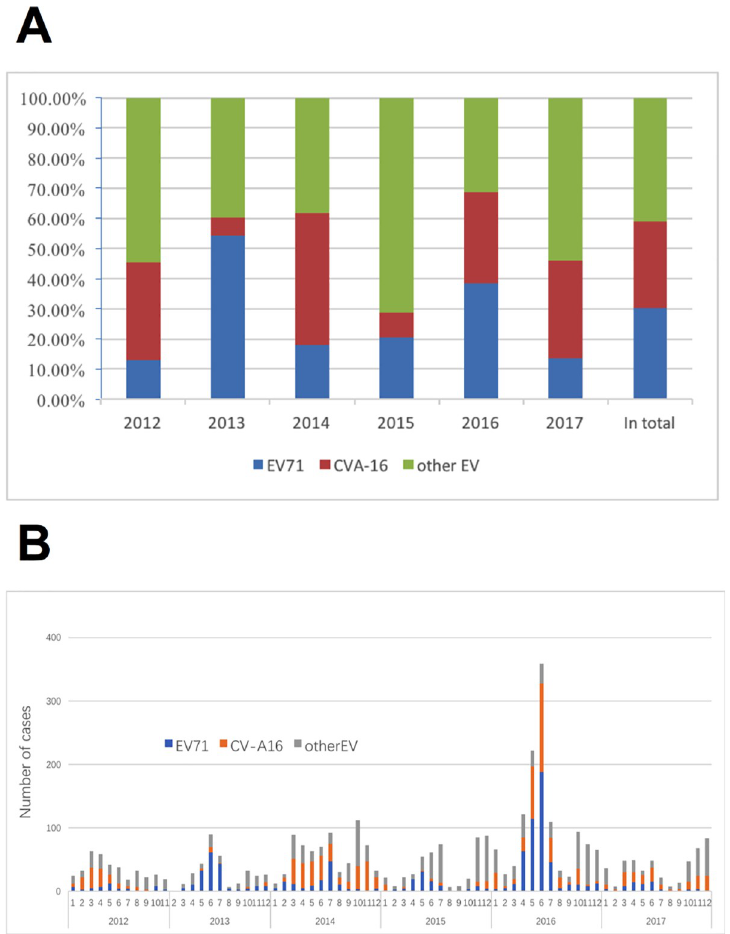
Fig 4. The yearly and monthly distribution and constituent ratio of the enterovirus serotype associated with confirmed HFMD cases in Neijiang, Sichuan, China, 2012–2017. A) Yearly distribution; B) Monthly